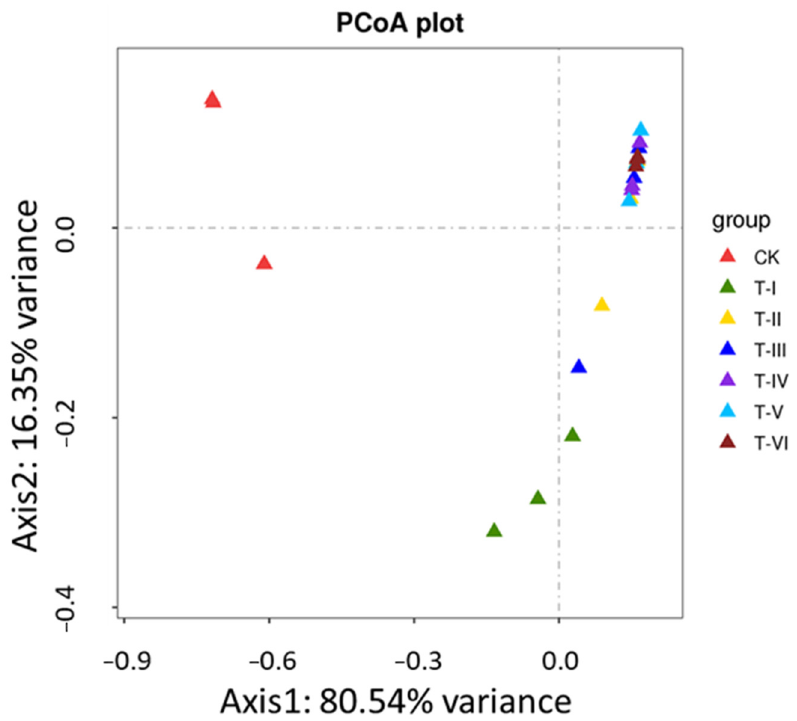
Figure 3. PCoA plot showing similarities and differences of potential main components at the evolutionary level in the samples. (Treatment codes indicate the samples fermented for 0 d (CK), 5 d (T-I), 10 d (T-II), 15 d (T-III), 20 d (T-IV), 25 d (T-V) and 30 d (T-VI).